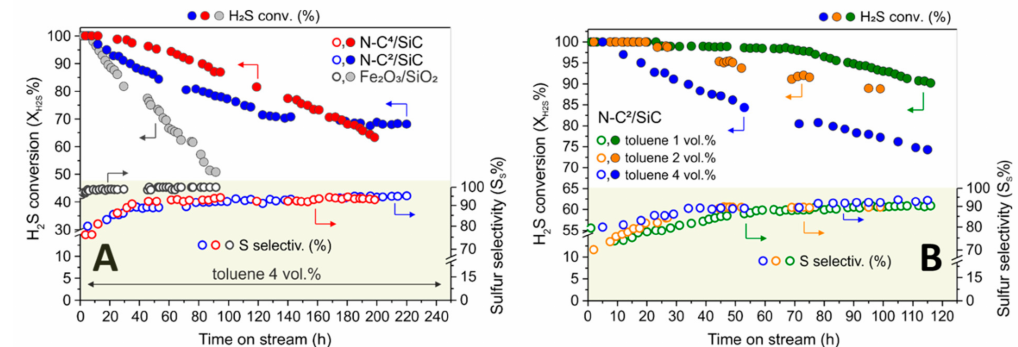
Figure 3. ( A ) Desulfurization performance on N-C 2 /SiC, N-C 4 /SiC and Fe 2 O 3 /SiO 2 catalysts of an acid gas stream ([H 2 S] = 0.3 vol.%) in the presence of 40,000 ppm of toluene (4 vol.%) as contaminant in the stream. Catalysis details: 6 g (V cat ~ 7.5 cm 3 for N-C 4 /SiC and N-C 2 /SiC) or 6 g (V cat ~ 5.8 cm 3 for Fe 2 O 3 /SiO 2 ); O 2 -to-H 2 S ratio = 2.5, [H 2 O] = 10 vol.%, He (balance); reaction temperature = 210 ◦ C, GHSV (STP) = 3200 h − 1 . ( B ) Desulfurization performance on N-C 2 /SiC at variable toluene concentrations (10,000, 20,000 and 40,000 ppm or 1, 2 and 4